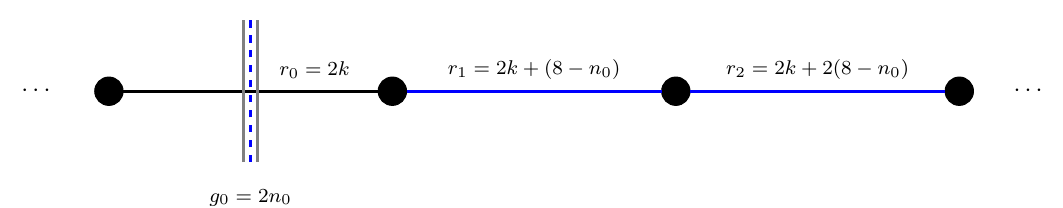
(a) NS5-D6-D8-O8 con(cid:12)guration with an O8 + -plane between an NS5 and its image, and crossing the 0-th D6 stack. A red dashed line and two vertical black lines represent an O8 + overlaid onto n 0 pairs of D8-branes, engineering a USp(2 n 0 ) (cid:13)avor group and contributing 2 n 0 half-hypermultiplets. A blue (gray) horizonatal line represents a D6 stack engineering an SU ( SO) gauge group.